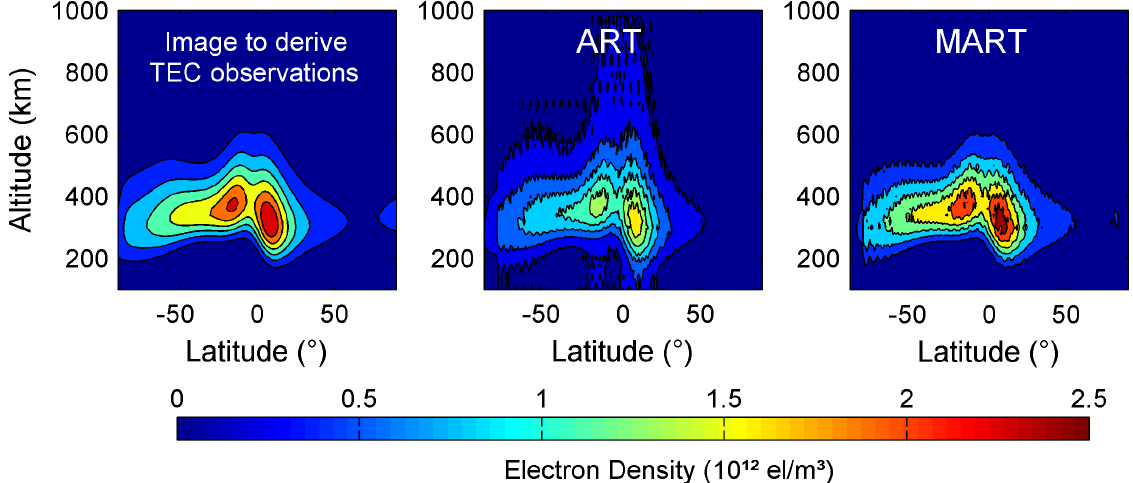
Figure 3 - 2D algebraic technique performance in Case I (larger electron density